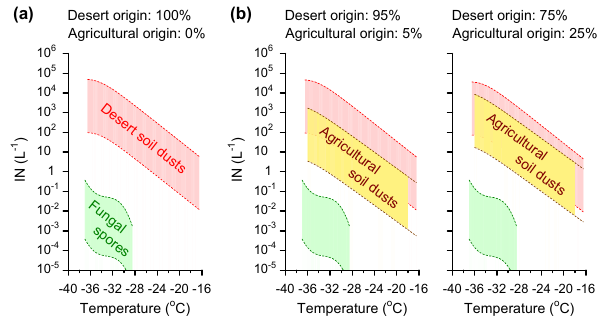
Figure 6. Estimates of global mean number concentrations of IN active under mixed-phase cloud conditions. (a) IN number concen- trations for soil dusts, assuming that all dusts are of desert origin. (b) IN number concentrations for desert and agricultural soil dusts, assuming that 5 and 25% of all dusts are of agricultural origin. Cal- culations are performed using the n s parameterizations for desert soil dusts (Niemand et al., 2012) and for untreated agricultural soil dusts (Fig. A1a) and the range of the zonal annual mean concen- trations of dusts at 600hPa (lower and upper limits) (Hoose et al., 2010; Murray et al., 2012). Also provided for comparison are IN number concentrations for fungal spores estimated using the n s pa- rameterization for Cladosporium spores (Iannone et al., 2011; Mur- ray et al., 2012) and the range of the zonal mean concentrations of fungal spores at 600hPa (lower and upper limits) (Hoose et al., 2010; Murray et al.,